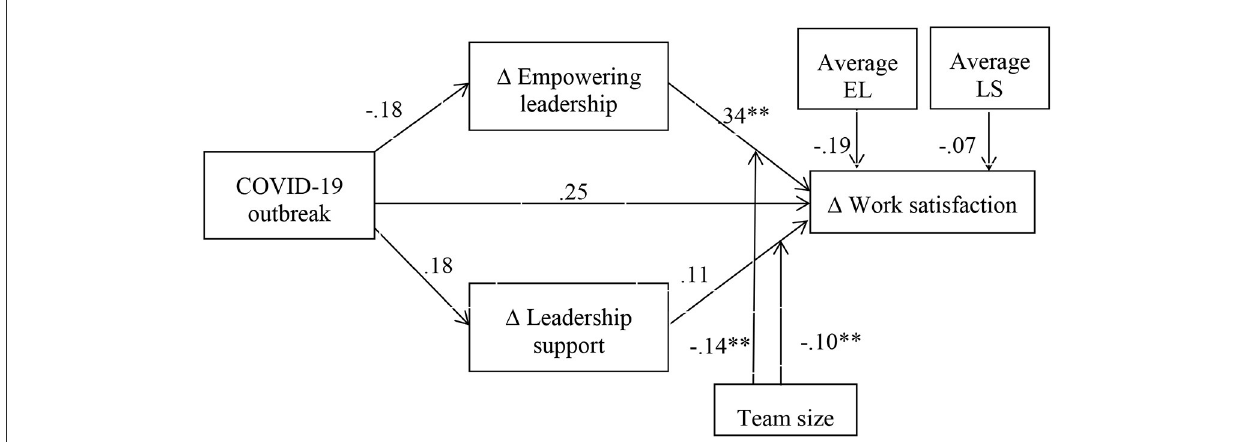
FIGURE1 The overall moderated mediation results for change in work satisfaction as a function of change in empowering leadership and leadership support after the COVID-19 outbreak. ** p < 0.01; EL, empowering leadership; LS, leadership support; 1 empowering leadership, empowering leadership before COVID-19 minus empowering leadership after the COVID-19 outbreak (change in empowering leadership due to COVID-19); 1 leadership support, leadership support before the COVID-19 outbreak minus leadership support after the COVID-19 outbreak (change in leadership support due to COVID-19); 1 work satisfaction, work satisfaction before the COVID-19 outbreak minus work satisfaction after the COVID-19 outbreak (change in wellbeing due to